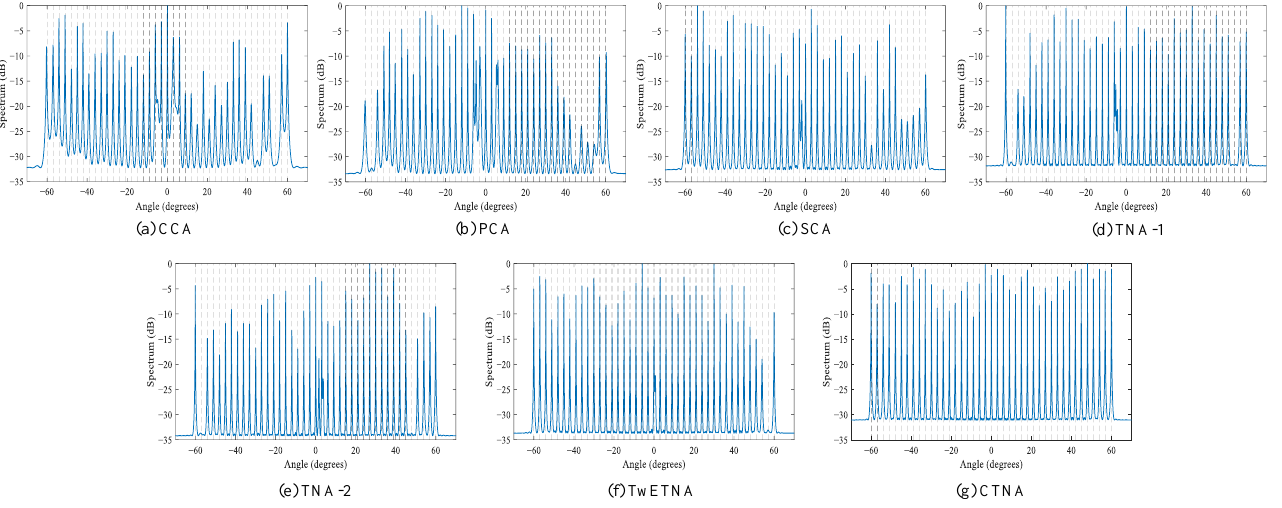
Figure 6. The VCAM spatial spectra for the considered sparse arrays with R = 16 sensors, where SNR = 0 dB, T = P = 800 and | c 1 | = 0.2. ( a ) CCA. ( b ) PCA. ( c ) SCA. ( d ) TNA-1. ( e )TNA-2.